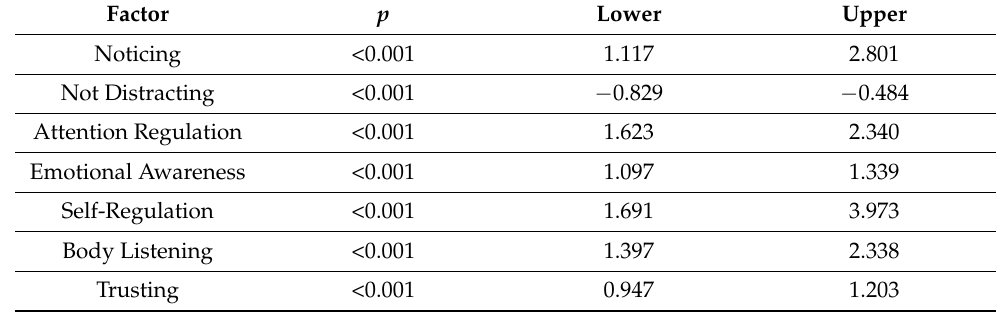
Table 10. Adjusted factor loading.